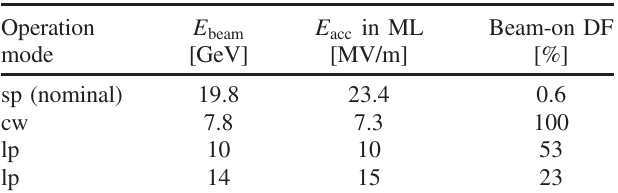
TABLE VI. Beam energy and DF estimated for the upgraded XFEL accelerator.